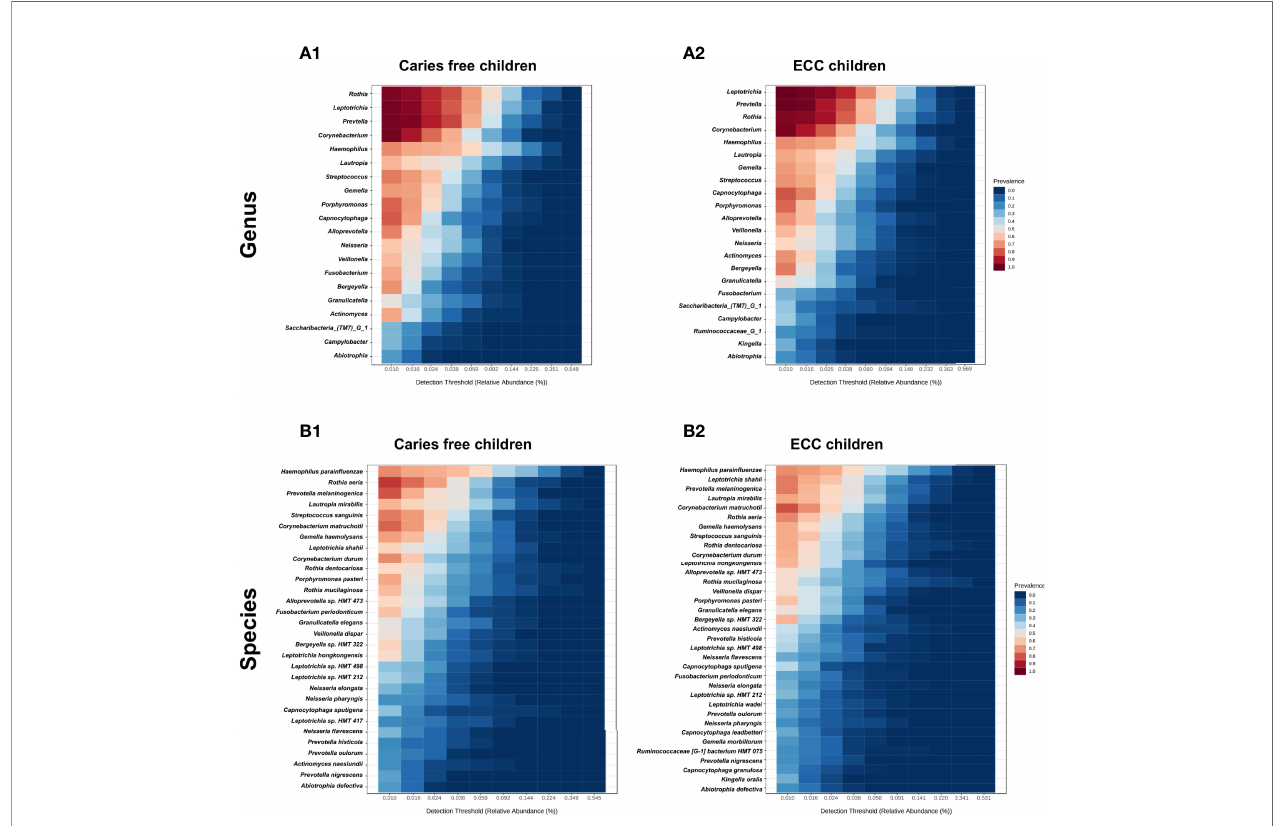
FIGURE 3 | Core salivary microbiome of ECC and carries-free children. Taxa at the genus and species level with more than 20% prevalence and more than 0.01% relative abundance are depicted. in caries free children (A1, B1) and ECC children (A2, B2)